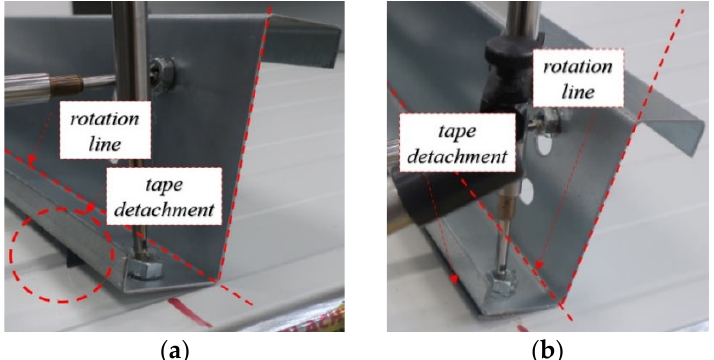
Figure 16. Cross-section rotation without bow web deformation: ( a ) pointwise tape (TP), ( b ) continuous tape (TL).